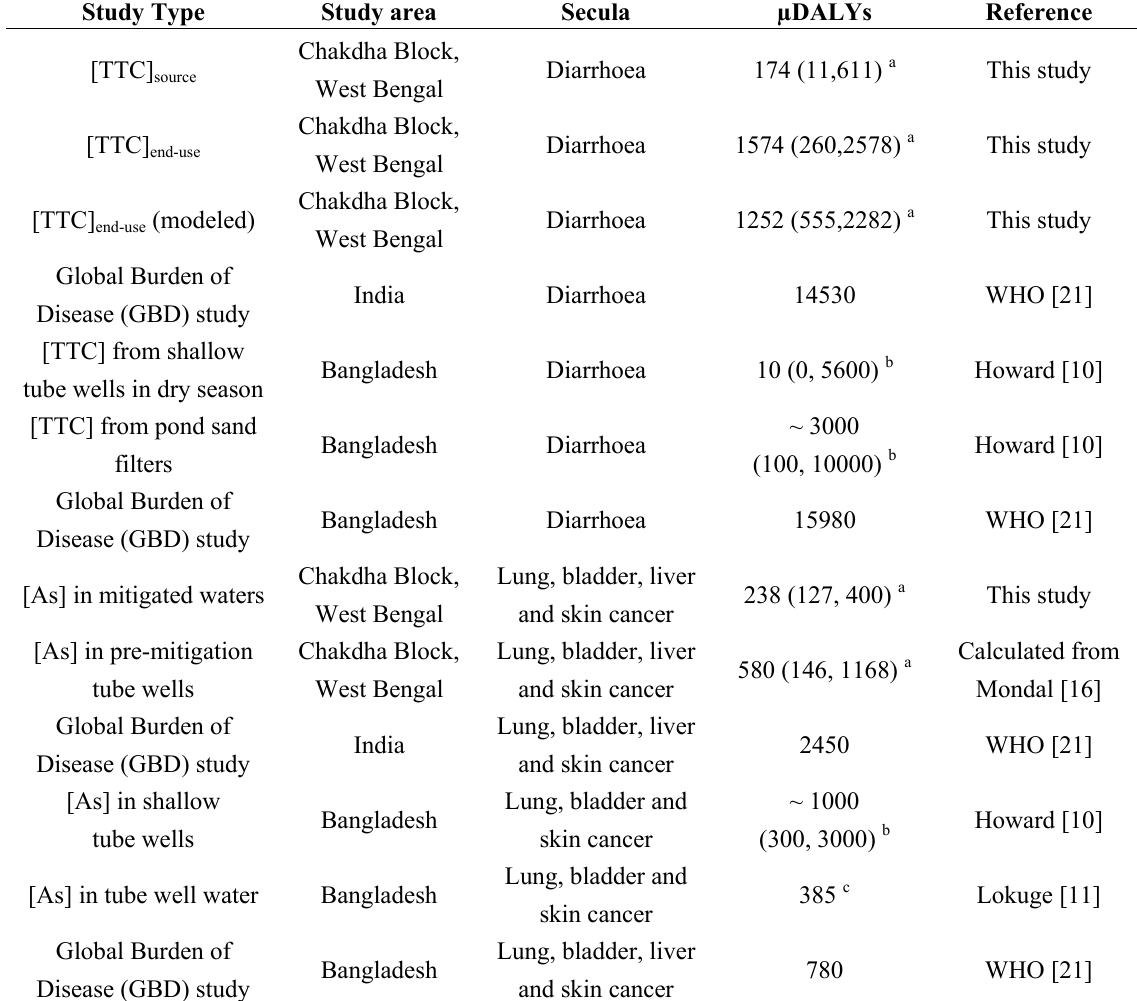
Table 7. Comparison of disease burdens (expressed in µDALYs/person/year) from exposure to waterborne arsenic or pathogens or global country-wide